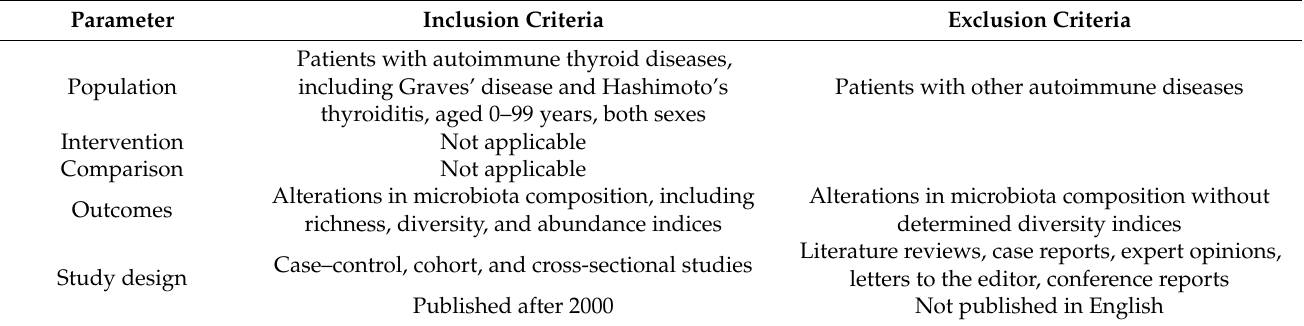
Table 6. Inclusion and exclusion criteria according to the